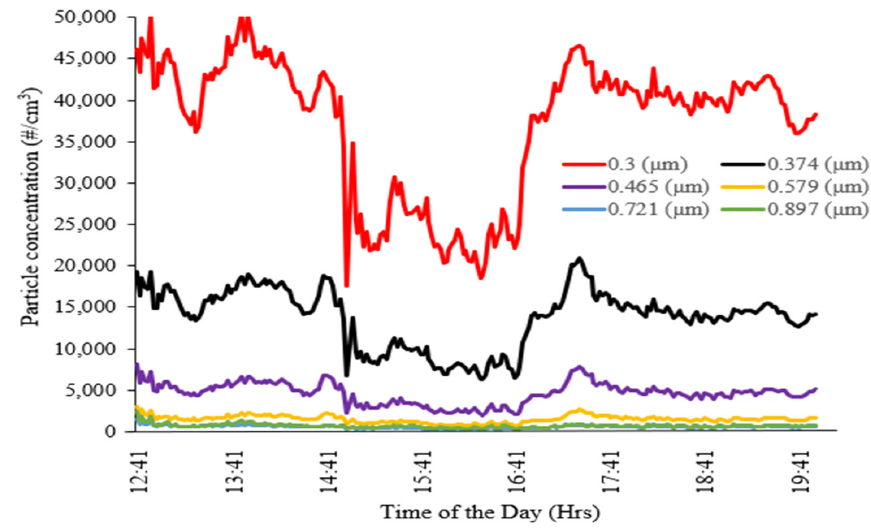
Figure 6. Size segregated sub ‐ micron PM particle number variations at the Port of Albany on 15 November 2018. 15 November